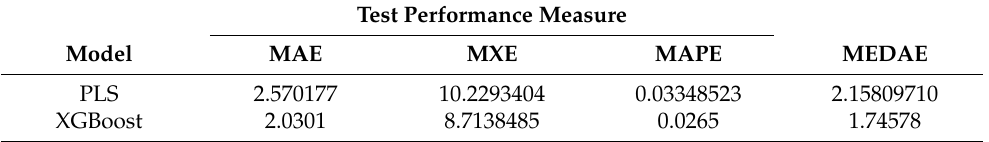
Table 3. Performance metric of PLS and XGBoost models in the test set (unseen subjects). The performance measures shown in the table are the maximum absolute error (MAE), the maximum residual error (MXE), the mean absolute percentage error (MAPE), and the median absolute error